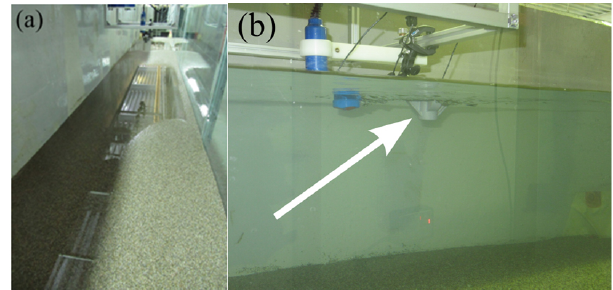
Figure 4. Hands-on session during W.A.T.E.R. 2019 in the Hy- draulics Laboratory of the University of Bologna (Italy): (a, b) two- component velocity profile measurements with ADCP provided by UBERTONE.